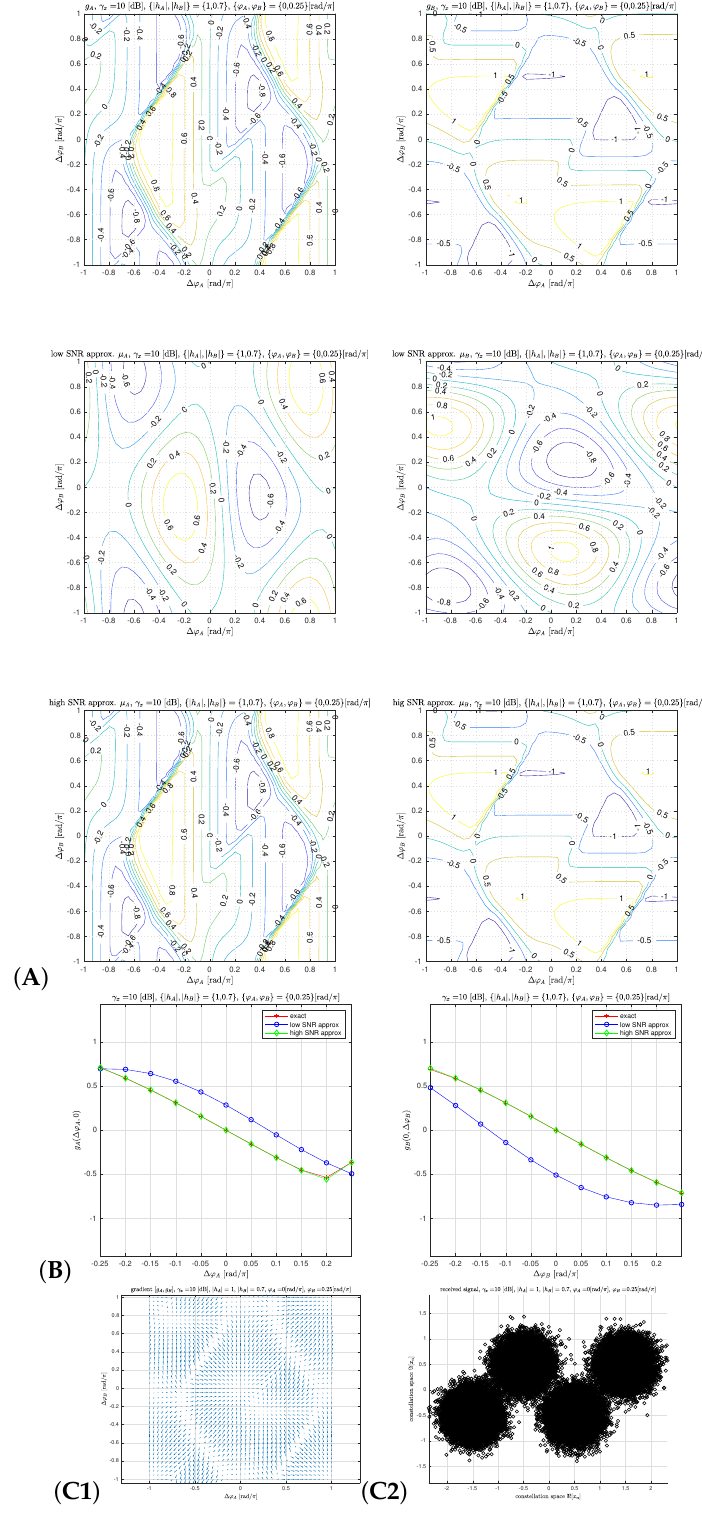
Figure 3. Equivalent detector characteristics for γ x = 10 dB, h A = 1e j0 , h B = 0.7e j0.25 π . ( A ) detector components g A ( ∆ ϕ ) , g B ( ∆ ϕ ) (row #1) exact , (row #2) low SNR approximation, (row #3) high SNR approximation; ( B ) detector components g A ( ∆ ϕ A ,0 ) , g B ( 0, ∆ ϕ B ) ; ( C1 ) gradient directions (exact); ( C2 ) random received constellation